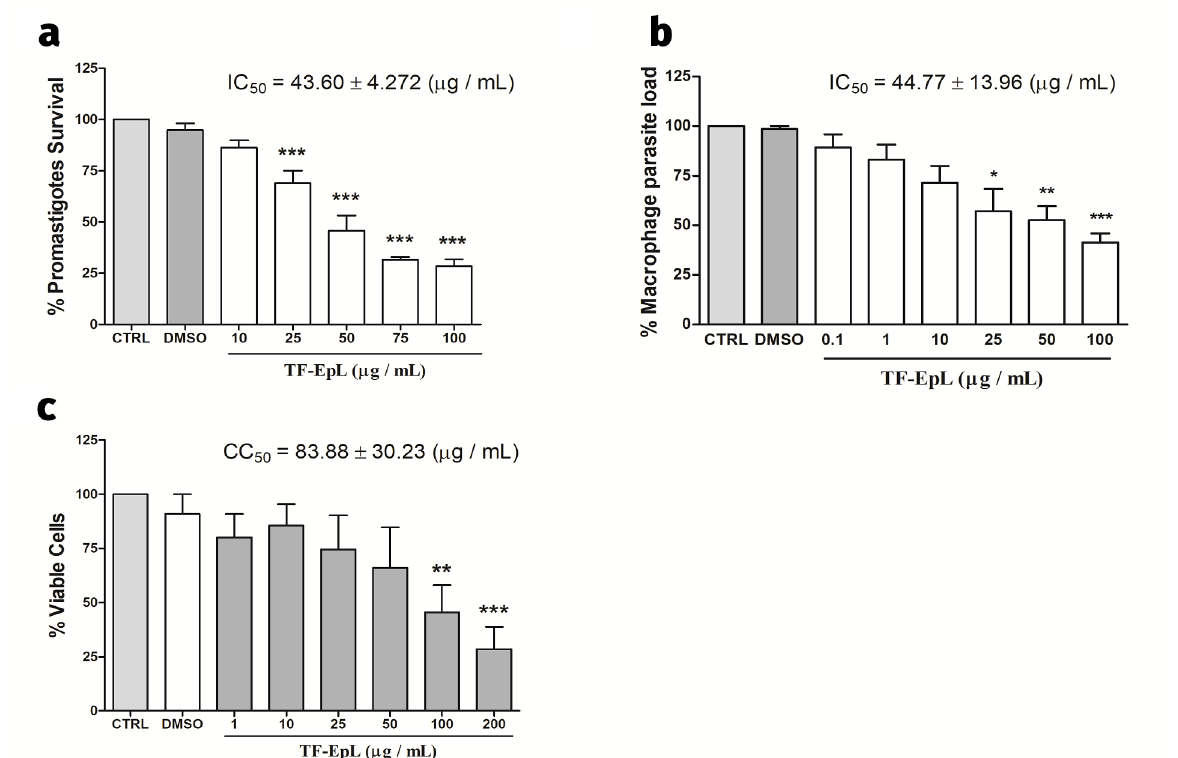
Figure 1. Inhibition of L. amazonensis proliferation by terpenoid fraction of E. pruniformis leaves (TF-EpL) and cytotoxicity against murine peritoneal macrophages in vitro . (a) Promastigotes (10 7 / mL) were grown in the presence or absence of TF-EpL, or diluent (DMSO), at the indicated concentrations, during 24 h. Parasite viability was checked by the dehydrogenases activity using the MTT assay. The results were expressed as the percentage of viable promastigotes in relation to the untreated control (100 %) and are shown as the mean ± SEM of 3 independent experiments. (b) Peritoneal macrophages (10 5 ) from BALB/c mice were infected with promastigotes at a ratio of 10 parasites to 1 macrophage for 24 h and were either left untreated or were treated with the indicated concentrations of TF-EpL for 24 h, washed, fed with Schneider’s complete medium, and cultured at 26 °C. The macrophage parasite load was evaluated after 48 h using Alamar Blue. (c) Cells were cultured with 1, 10, 25, 50, 100 and 200 µg/mL TF-EpL for 24 h at 37 °C in 5 % CO . Viability was measured by the XTT method. The results 2 represent the means ± SEM from 3 experiments performed in triplicate. p < 0.05 (*), p < 0.001 (**) and p < 0.0001 (***) compared to the